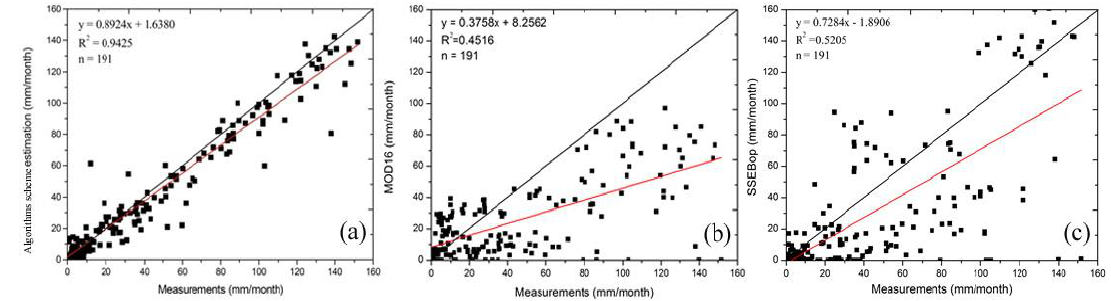
Figure 8. Estimated monthly ET from ( a ) the proposed algorithms scheme, ( b ) MOD16 ET product, and ( c ) SSEBop ET product as compared with eddy covariance (EC) observations at five stations in the Heihe River Basin from 2008 to 2014.